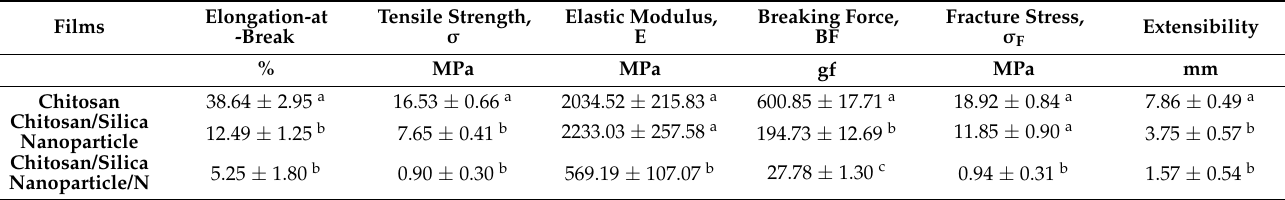
Table 1. Mechanical properties of the novel